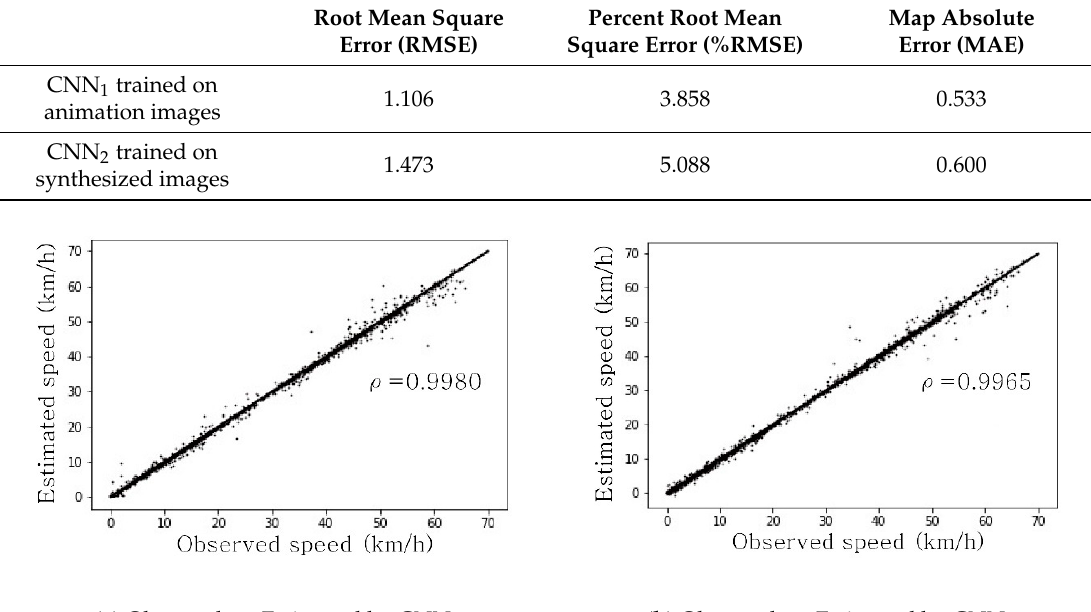
Figure 12. Comparison of observed and estimated space mean speeds estimated using artificial images. ρ : Correlation coefficient.